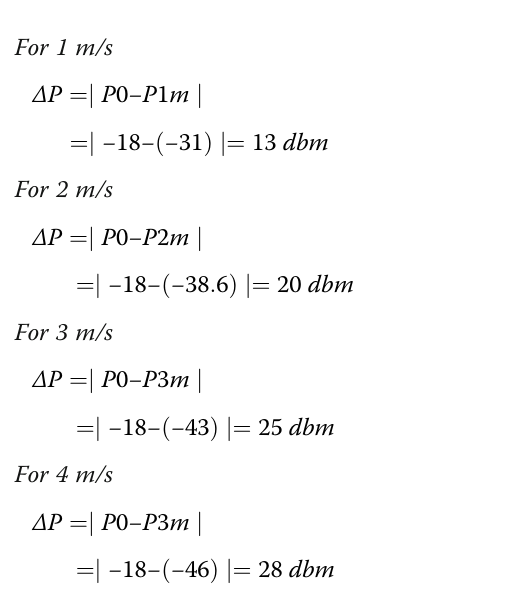
Fig. 4 Empirical CDF of scenario III. Calculates the empirical cumulative distribution function for 50, 55 and 60 ft. The x -axis represents the RSS data, while the y -axis represents the percentage value of each graph. It also shows the mean and standard deviation values of the three instances taken in the scenario